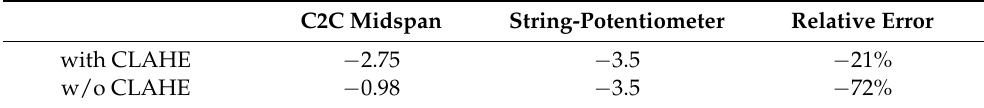
Table 13. Comparison of relative errors based on CLAHE